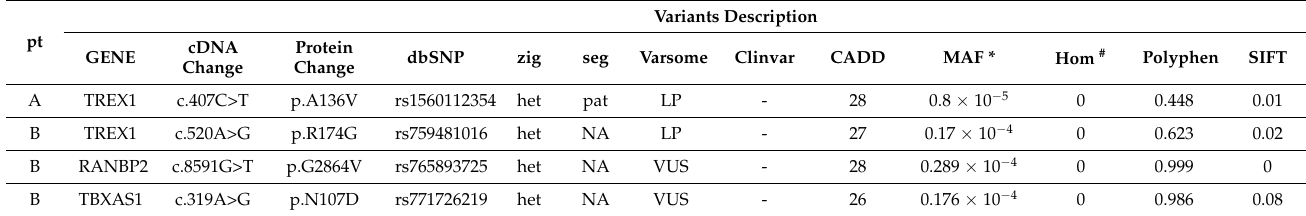
Table 1. genetic results obtained from the NGS ‐ panel analysis.